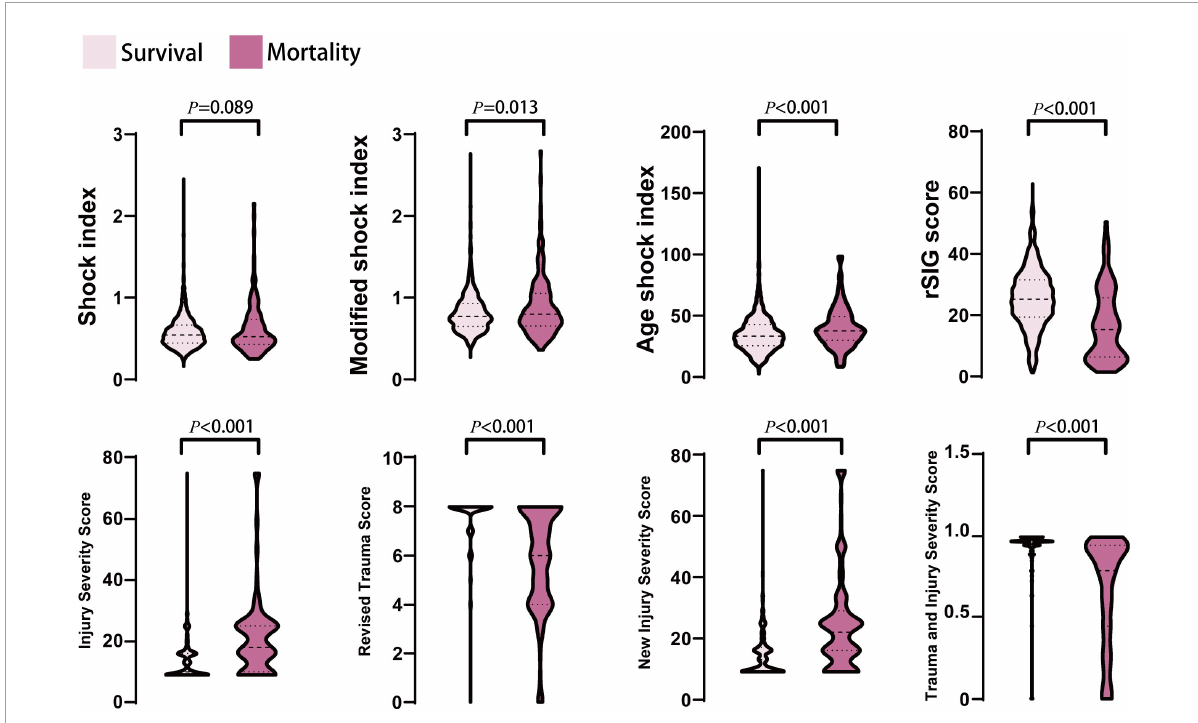
FIGURE2 The distribution and density of all prediction score systems in survival and mortality groups was illustrated in violin plot. Inside the violin plot interquartile ranges and outlier whiskers are presented as a thick and thin line equivalent to a boxplot. There were no statistical differences for shock index between survival and mortality